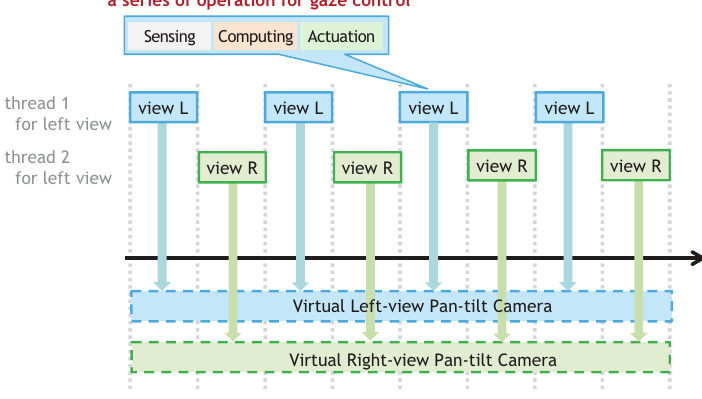
Figure 2. Time-division thread processes for virtual pan-tilt cameras in multithread gaze